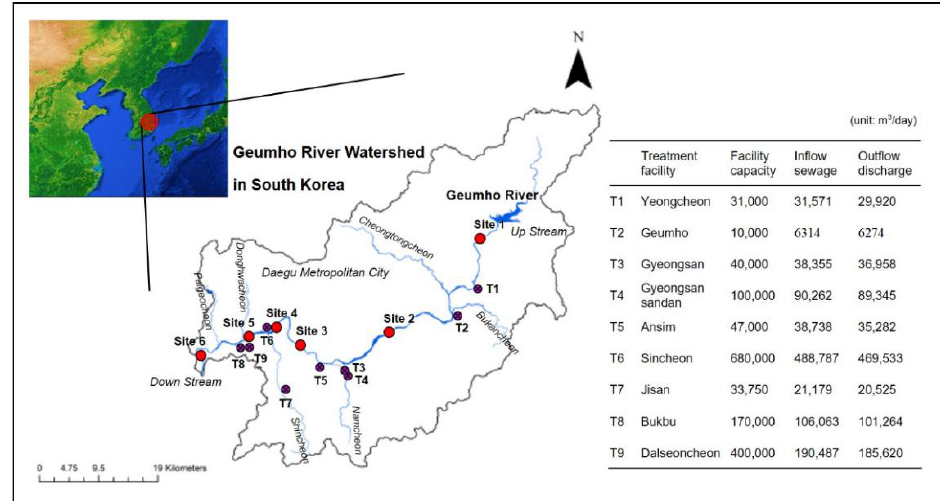
Figure 2. Locations of water monitoring sites and sewage and wastewater treatment facilities in the target watershed [30]. Red point, monitoring sites (S1 to S6); purple point, sewage and wastewater treatment facilities (T1 to T9).